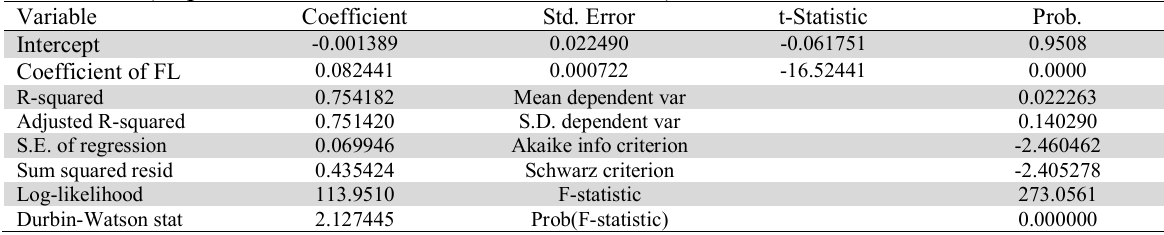
ROE model (Dependent variable: ROE, Observations: 357)